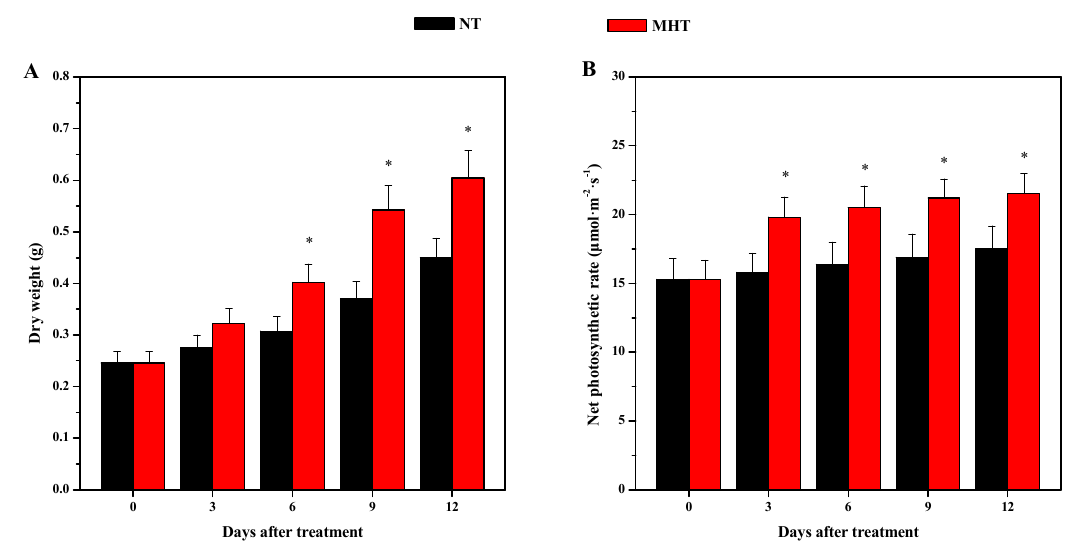
Figure 2. Dry weight ( A ) and net photosynthetic rate ( B ) of tobacco leaves grown at NT and MHT. The asterisk (*) indicates p < 0.05.